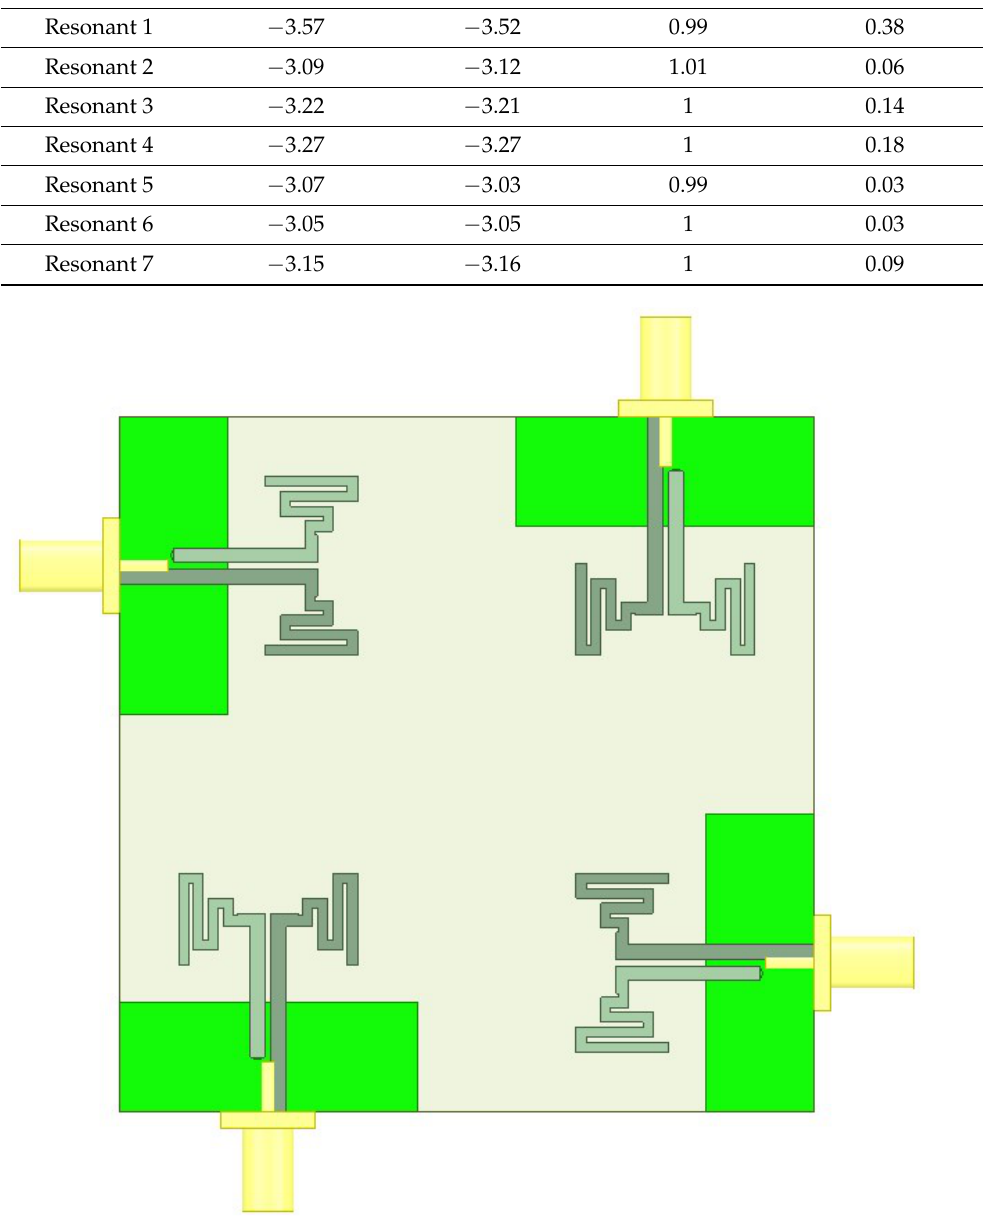
Figure 9. Four-element MIMO antenna configuration.